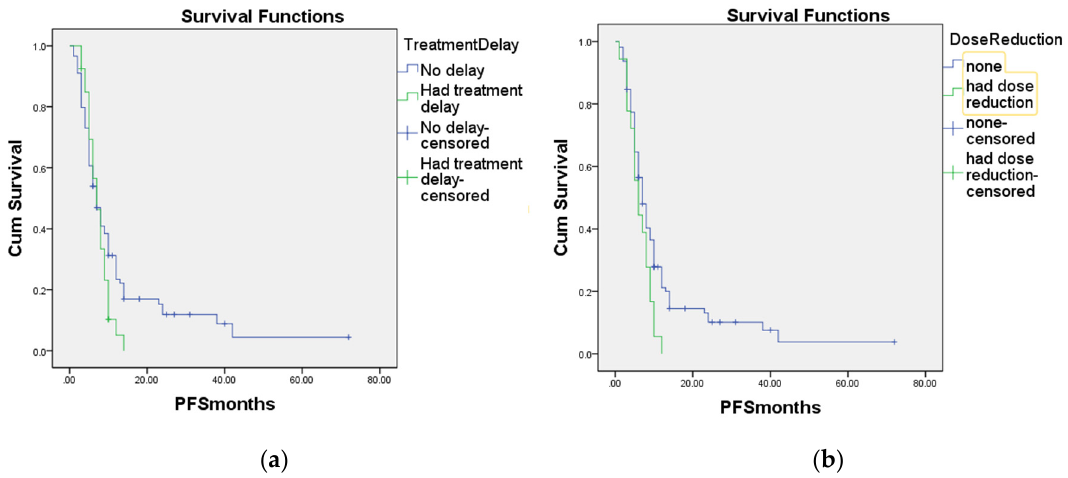
Figure 1. Progression free survival in the ( a ) dose reduction subgroup vs. ( b ) no dose reduction and in the treatment delay group vs. no treatment delay.